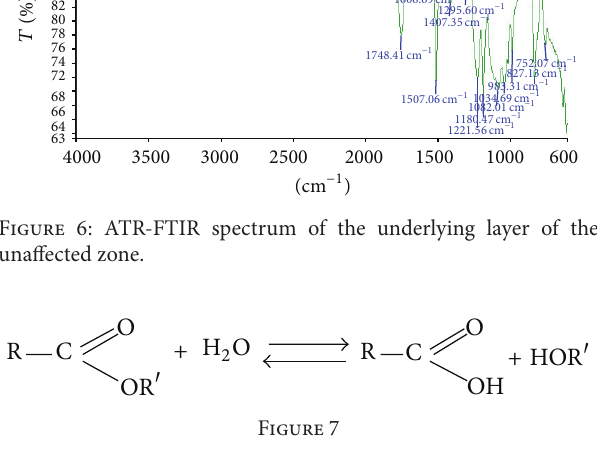
phenolic groups and at 1507 cm −1 and 1605 cm −1 by C=C